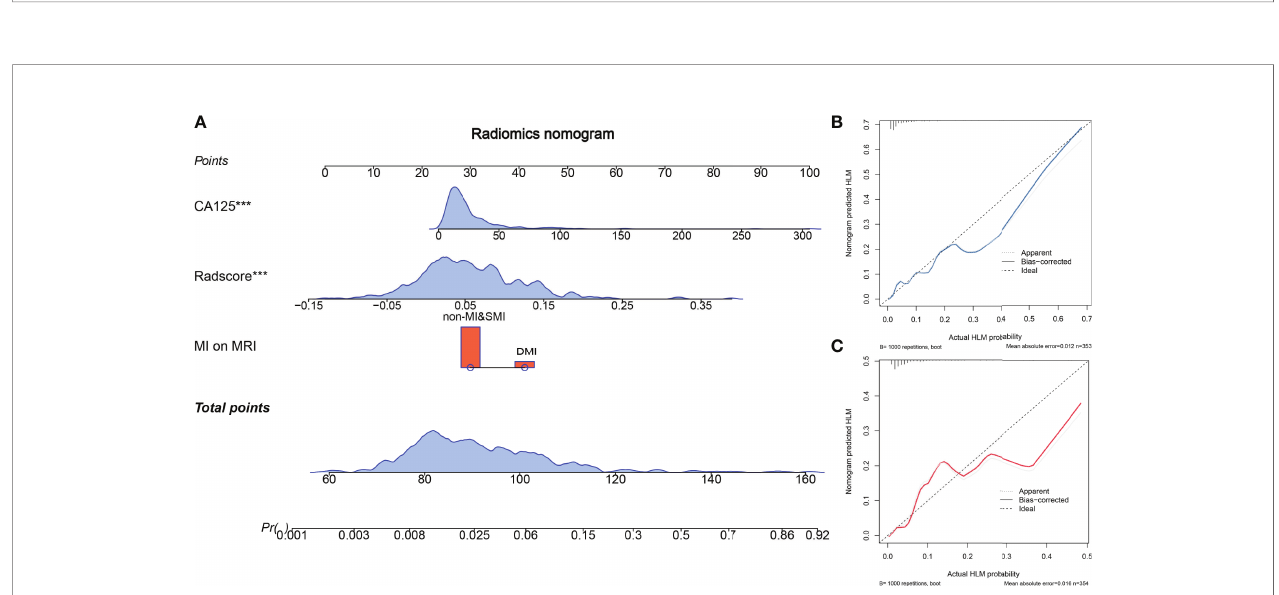
FIGURE 2 | Feature selection using LASSO and the selected radiomics signatures and co-occurrence of radiomics signatures and clinical features. The parameter lambda is chosen using 10-fold cross-validation via minimum criteria, which resulted in 10 features with nonzero coef fi cients (A) . LASSO coef fi cient pro fi les of the selected features (B) . The selected radiomics signatures of LNM by the LASSO method (C) . A co-occurrence map shows the correlations between radiomics features and clinical features of LNM in early-stage EC (D) .